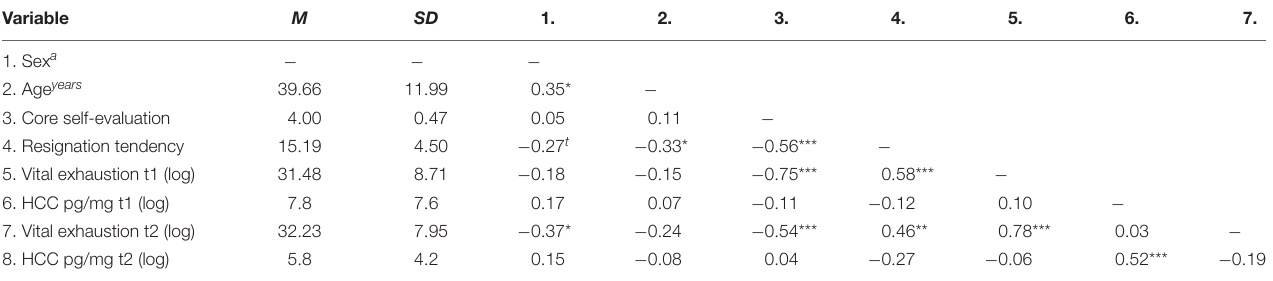
TABLE 1 | Descriptive statistics and intercorrelations of key variables.